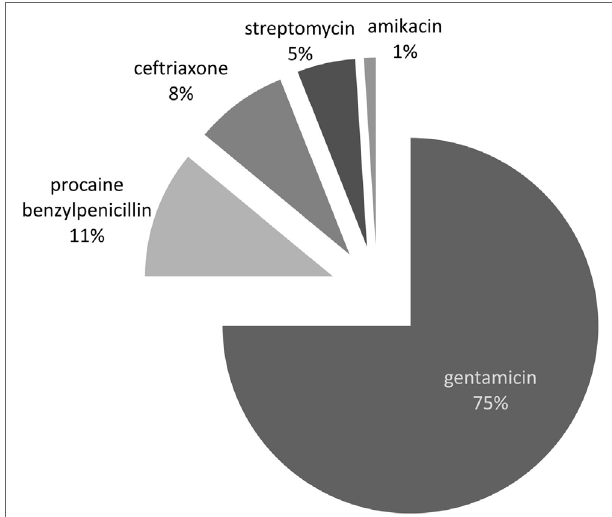
FigUre 1 | Parenteral outpatient antibiotic use in South Backa District expressed in percentage.